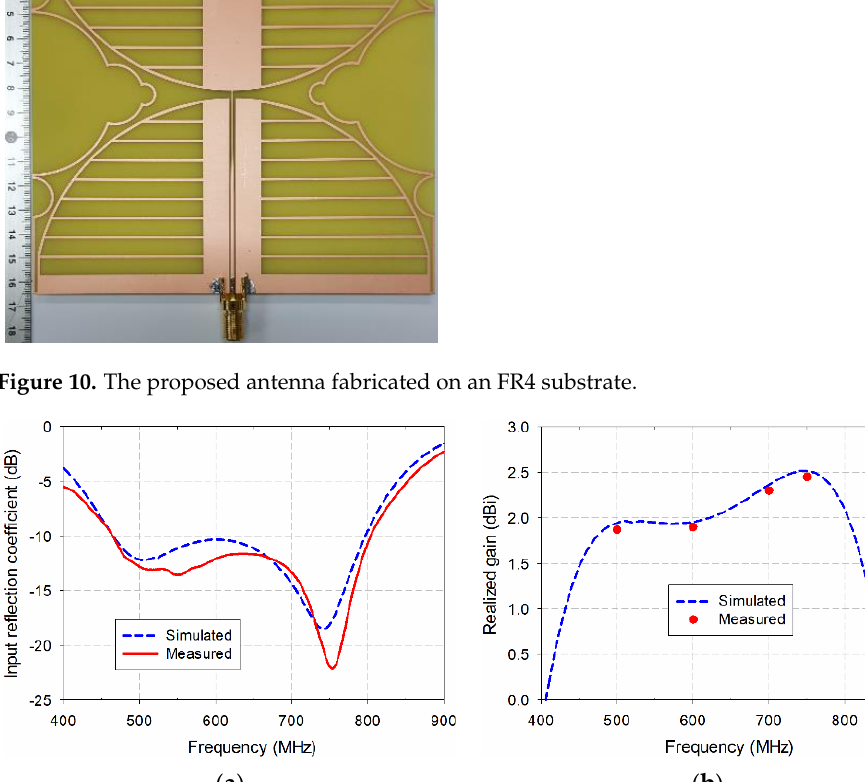
Figure 11. Performance comparison of the fabricated antenna: ( a ) input reflection coefficients; ( b ) realized gain.